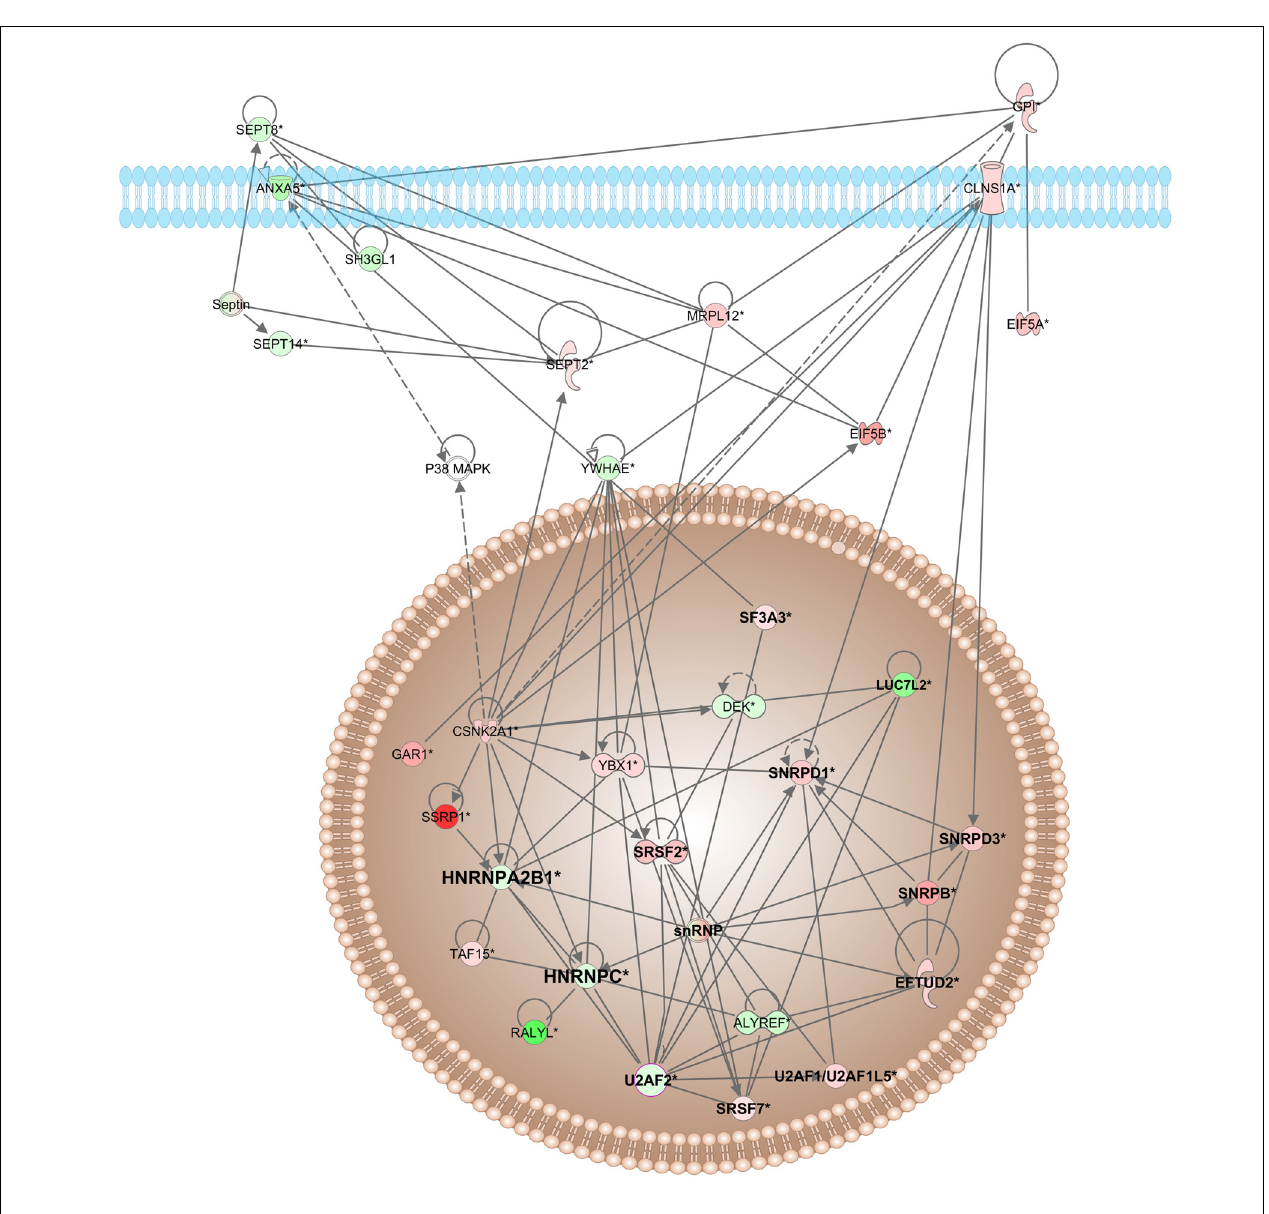
FIGURE 4 | Network interactions, and their interactors, of differentially expressed proteins of haloperidol-treated oligodendrocytes. The network was generated from differentially expressed proteins by IPA. Colored interactors represent proteins previous found in the proteome. Highlighted proteins were belonging to splicing machinery. Full and dashed lines depict direct and indirect connections,